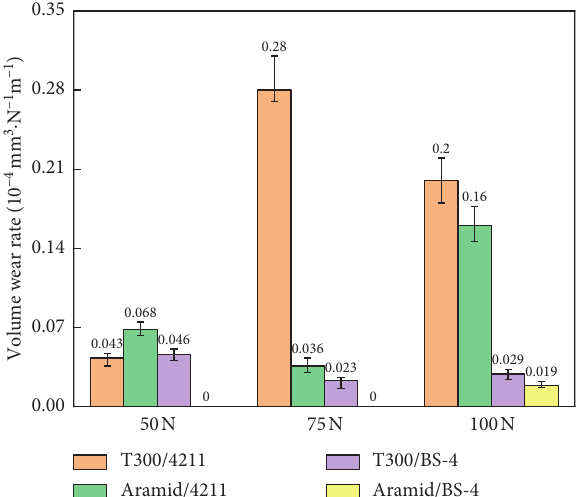
Figure 6: Wear rate of the composites coupled with the 45 steel metal pair under different